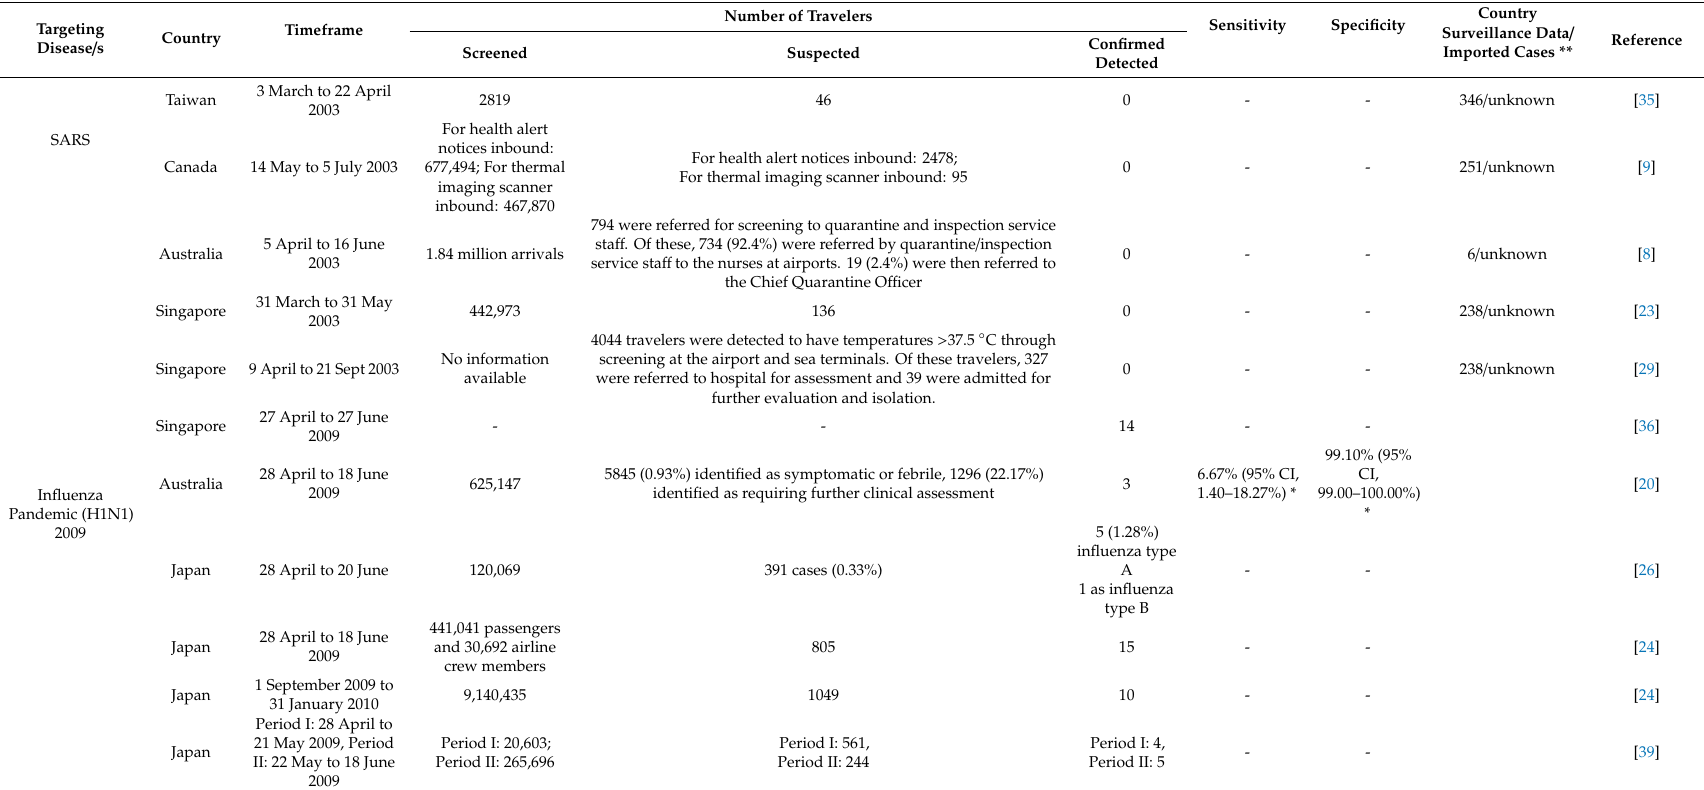
Table 7. Number of travelers screened, suspected and confirmed cases detected through entry